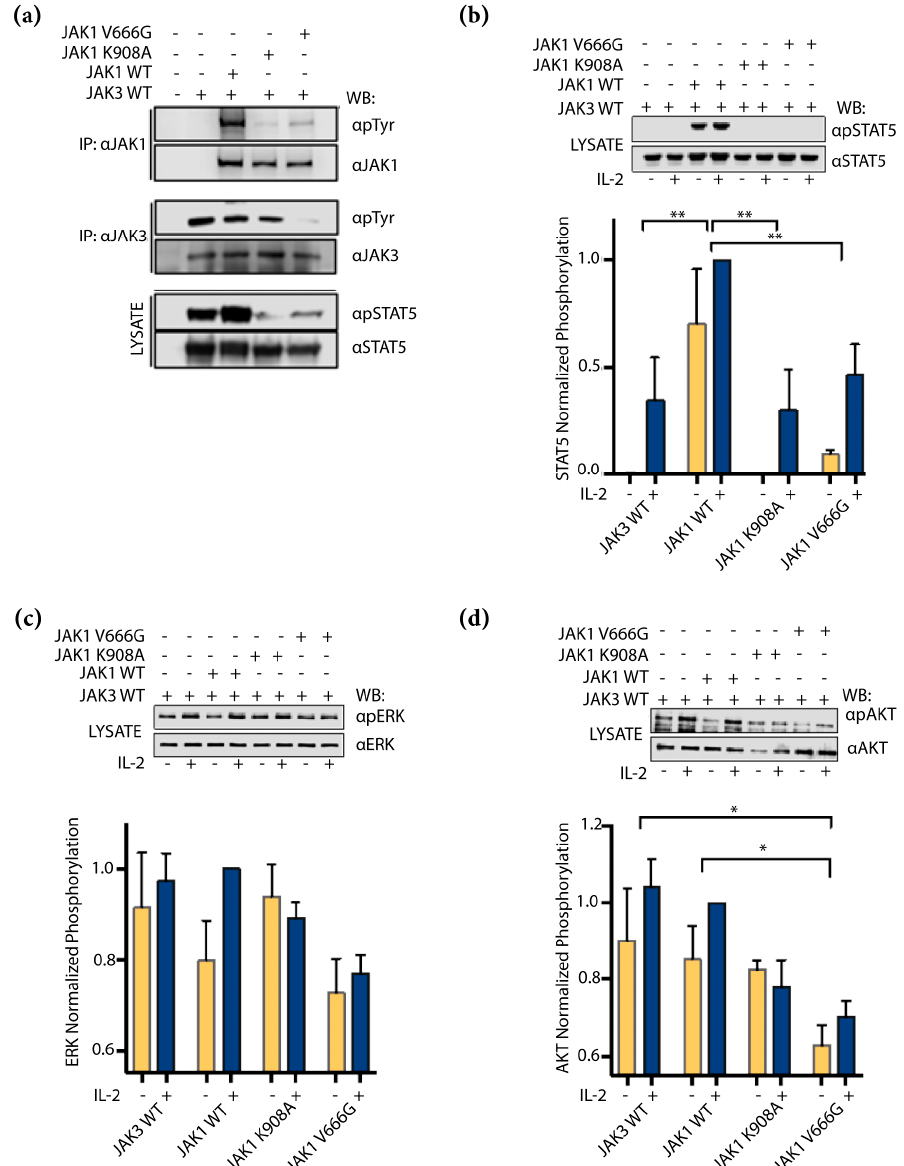
Figure 4. JAK1 V666G inhibits trans-activation of JAK3 and IL-2 signaling. Western blot (WB) of protein lysates from U4C cells non-transfected (NT) or transiently transfected with WT JAK1–MYC, JAK1 K908A, or V666G, along with JAK3, IL-2R β , γ c, and STAT5. ( a ) U4C cells expressing IL-2 signaling components, including overexpressed JAK1 and JAK3, were immunoprecipitated (IP) and examined for Tyr phosphorylation by WB. Corresponding lysate was used to examine Tyr phosphorylation of STAT5. Cells were not stimulated with IL-2. U4C cells expressing IL-2-signaling components, low-level JAK1 and JAK3, were challenged with IL-2 and total cell lysate was examined for ( b ) STAT5 ( n = 3), ( c ) ERK ( n = 3), and ( d ) AKT ( n = 4) phosphorylation. Graphed data include samples treated with or without IL-2 represented by normalized phosphorylation. Data were analyzed using a two-way ANOVA with a post hoc Tukey’s test for multiple comparisons. ** p < 0.0020 and * p < 0.0431.